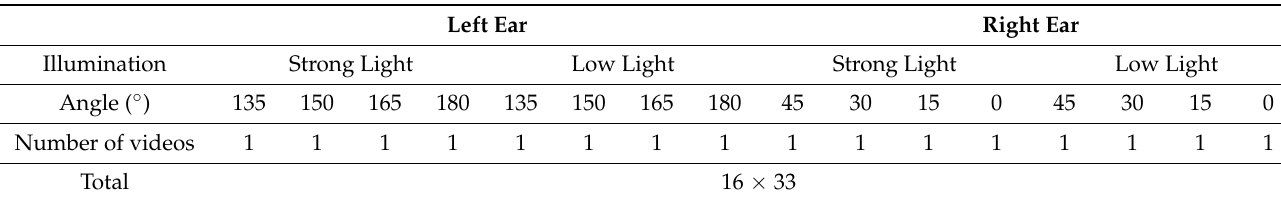
Table 5. Human ear database information of